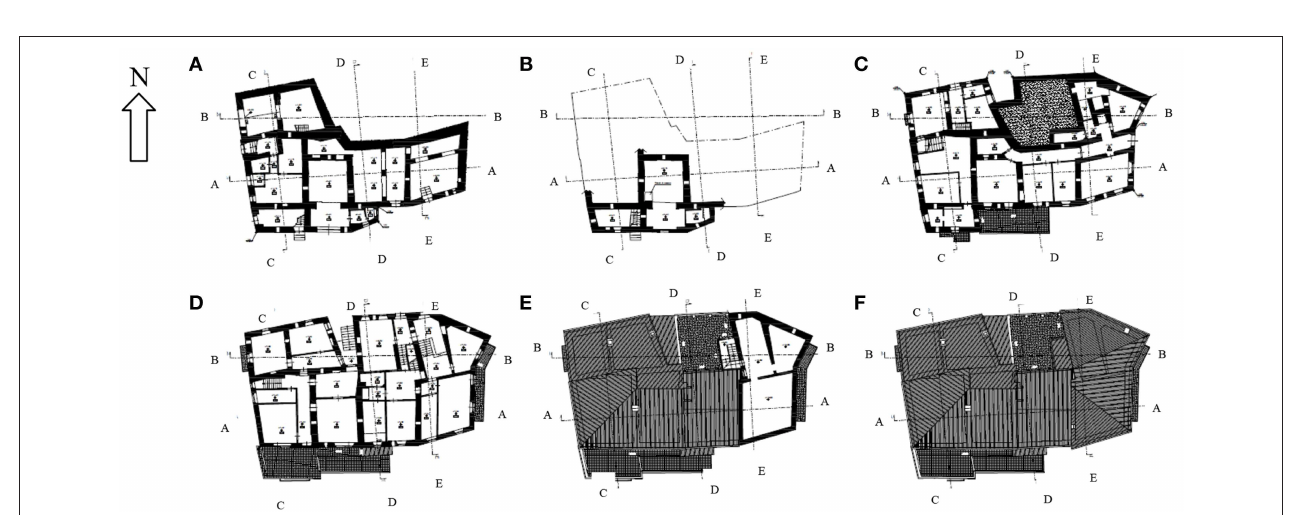
FIGURE 4 | Plan layouts of the building cluster under study: ground (A) , mezzanine (B) , first (C) , second (D) , attic (E) , and roof floors (F)